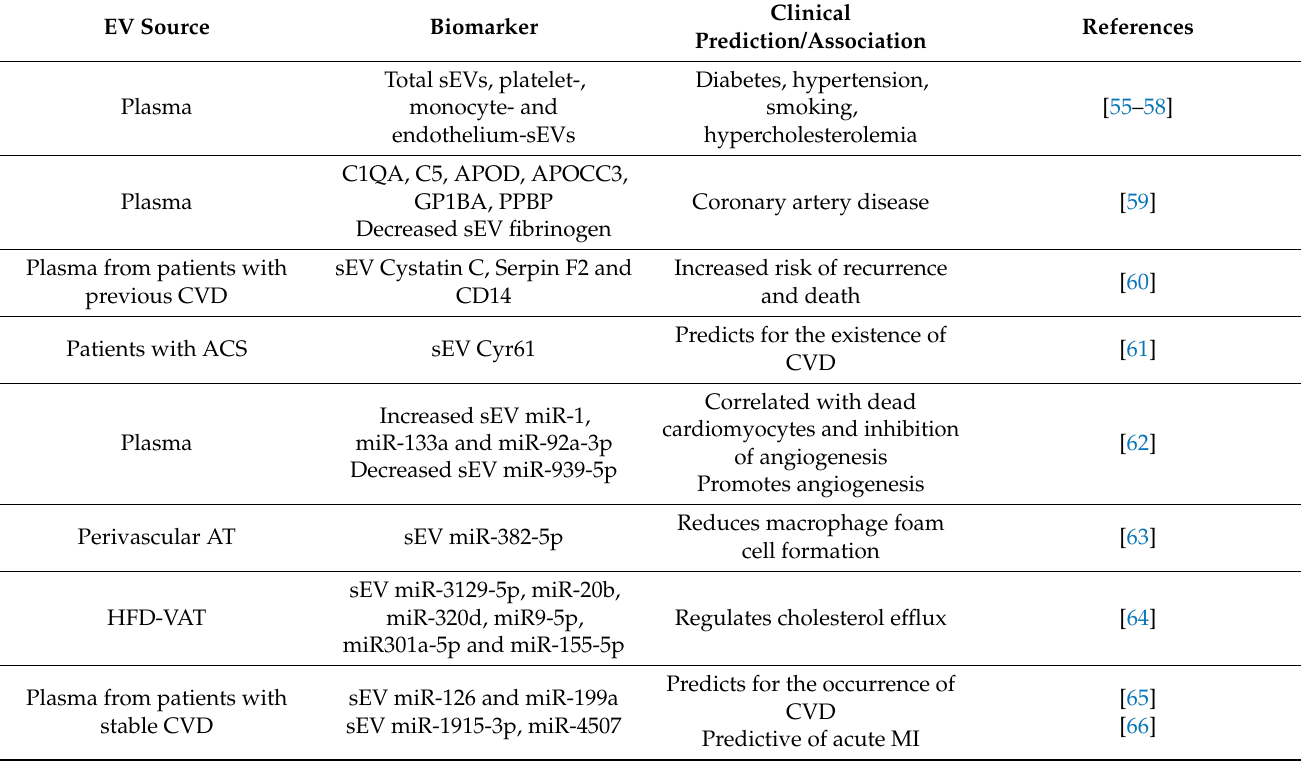
Table 2. Predictive potential of plasma